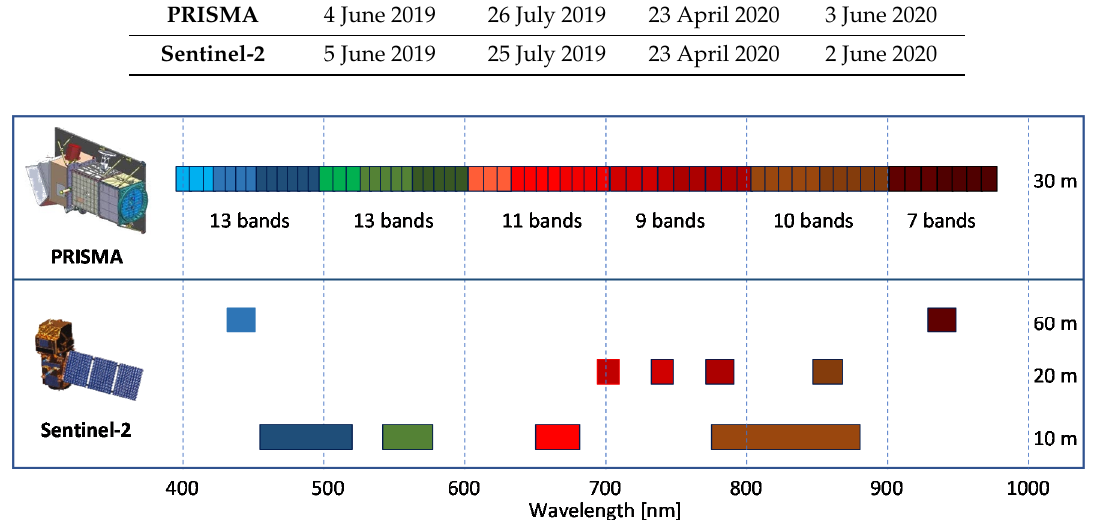
Table 1. PRISMA and Sentinel-2 acquisitions over Lake Trasimeno. PRISMA